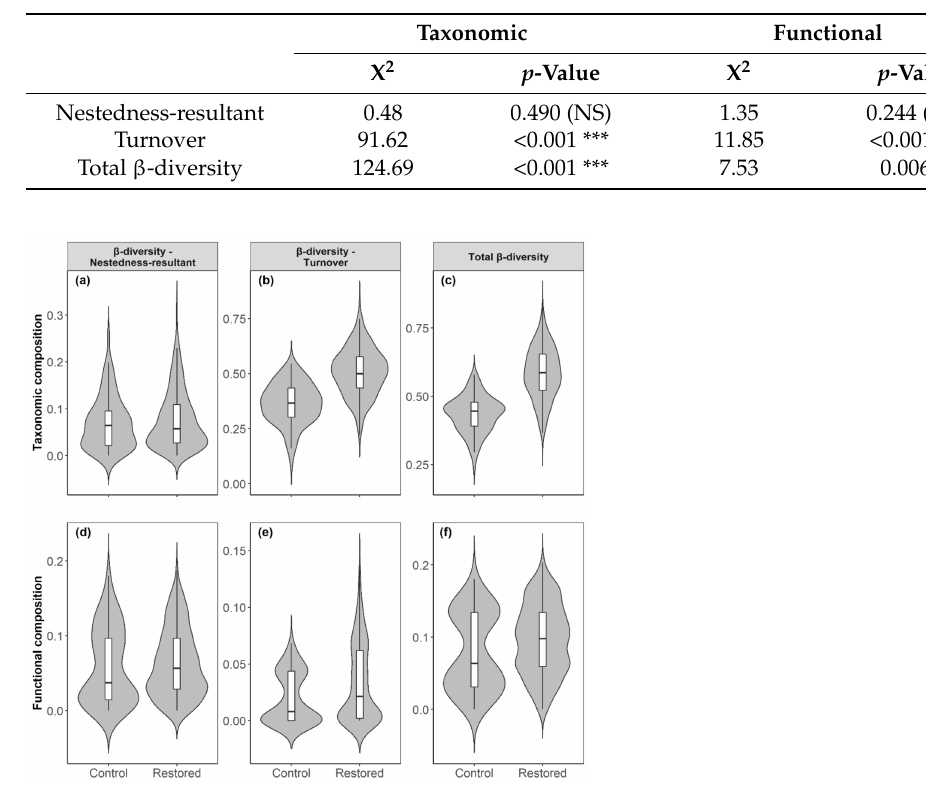
Figure 4. Violin and boxplots (whiskers indicate the range, while boxes indicate the 25th, 50th and 75th percentiles) showing differences in how taxonomic ( a – c ) and functional ( d – f ) β -diversity properties changed temporally (before versus after) between control and restored sites. The total β - diversity ( a , d ) was measured along with the turnover ( b , e ) and nestedness-resultant ( c , f )